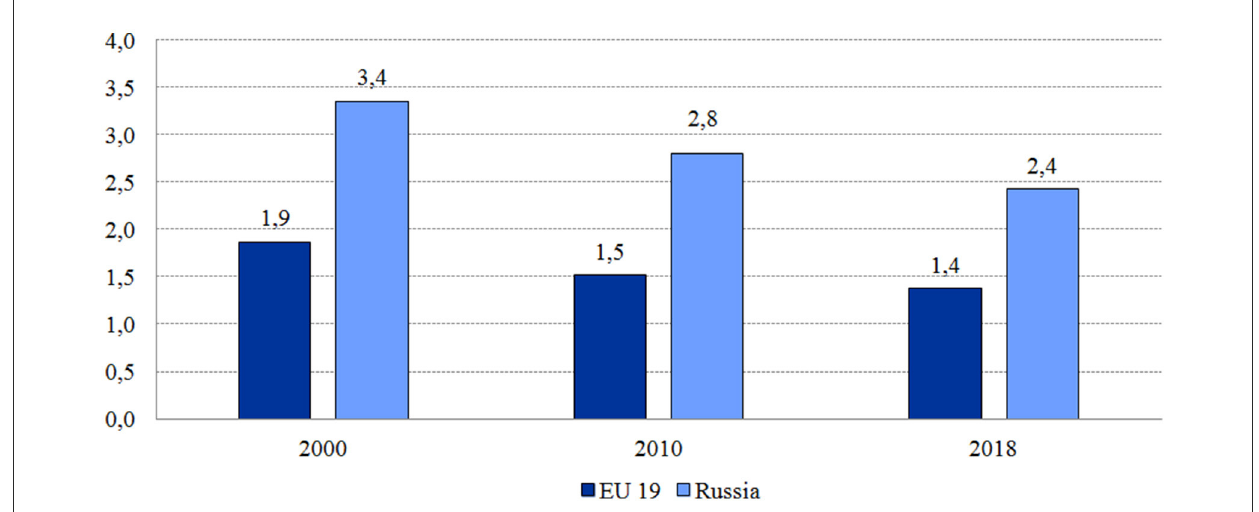
FIGURE3 Number of hospital bed-days per person in Russia and the EU average. Source :